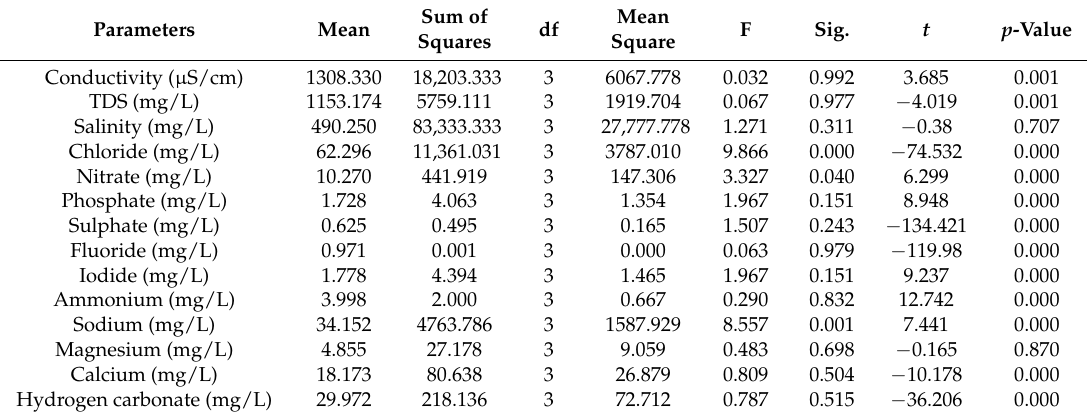
Table 6. The hypothetical test of the variation of the water parameters that constitutes to water salinity and the student t -test